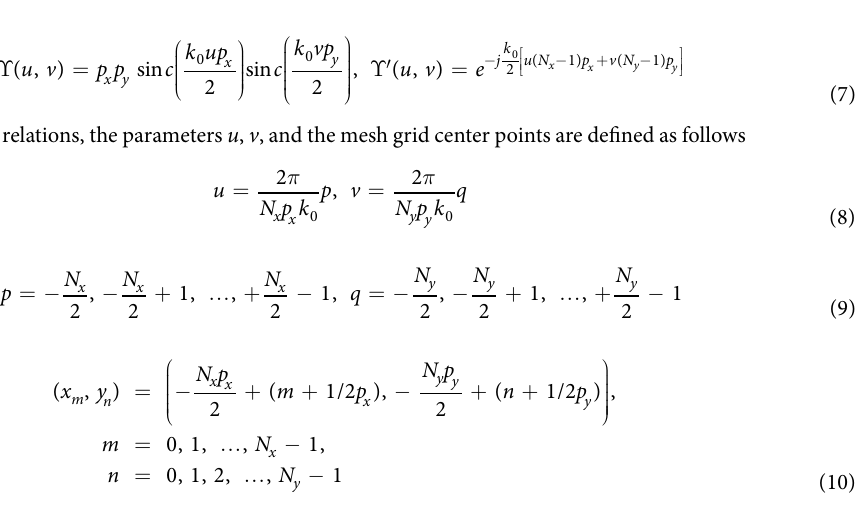
Figure 6. ( a ) Three-dimensional and ( b ) two-dimensional display of theoretical results of the object wave in the far field; ( c ) three-dimensional demonstration of the full wave simulation result of the object wave in CST software; ( d ) demonstration of the object wave in the two principal planes of the hologram. Note that the first plot of ( d ) is demonstrated in X ′ Z ′ -plane and the later plot is shown in the plane which is perpendicular to X ′ Z ′ - plane and contain the main beam direction that the peak gain occurs (i.e., θ = 20°, where θ is the polar angle in XYZ coordinate